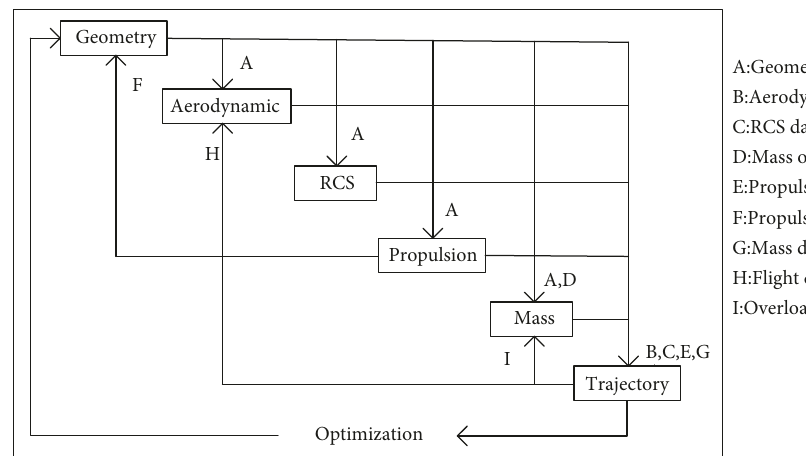
Figure 8: Relationship between all of the discipline codes.